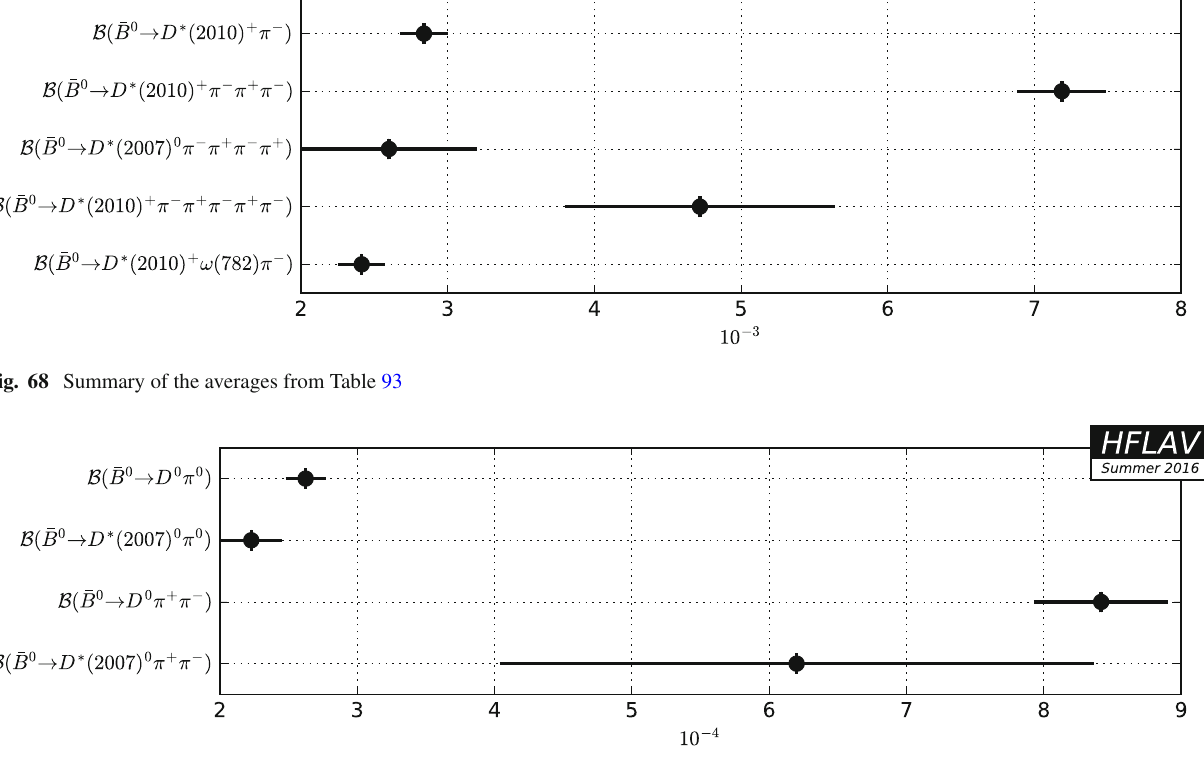
Fig. 69 Summary of the averages from Table